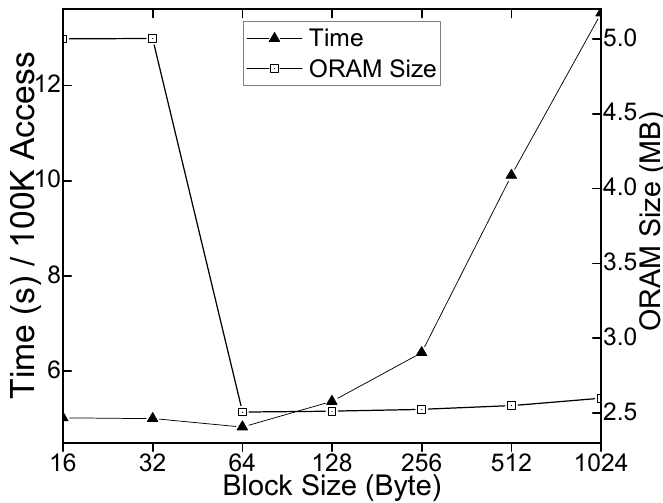
Figure 10. Block size selection for 450 KB